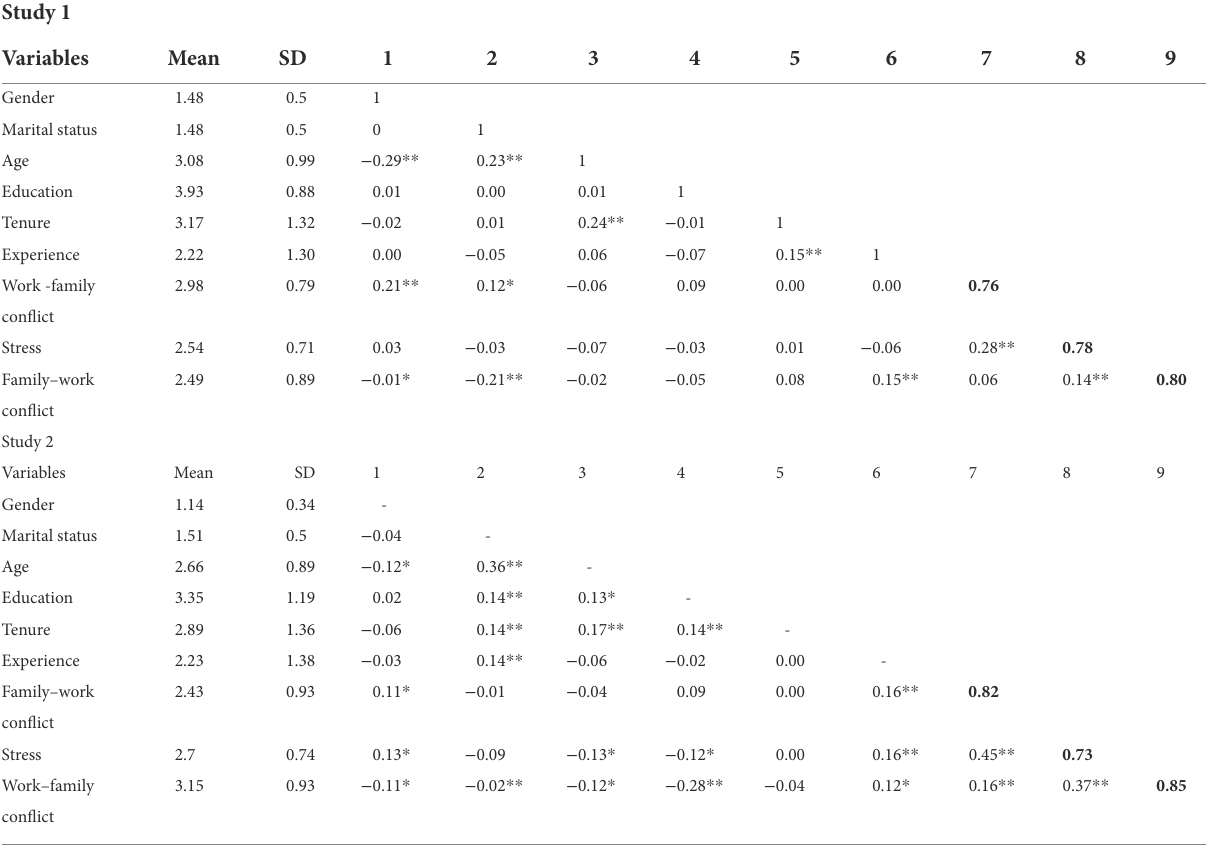
TABLE 3 Means, standard deviations, and intercorrelations.